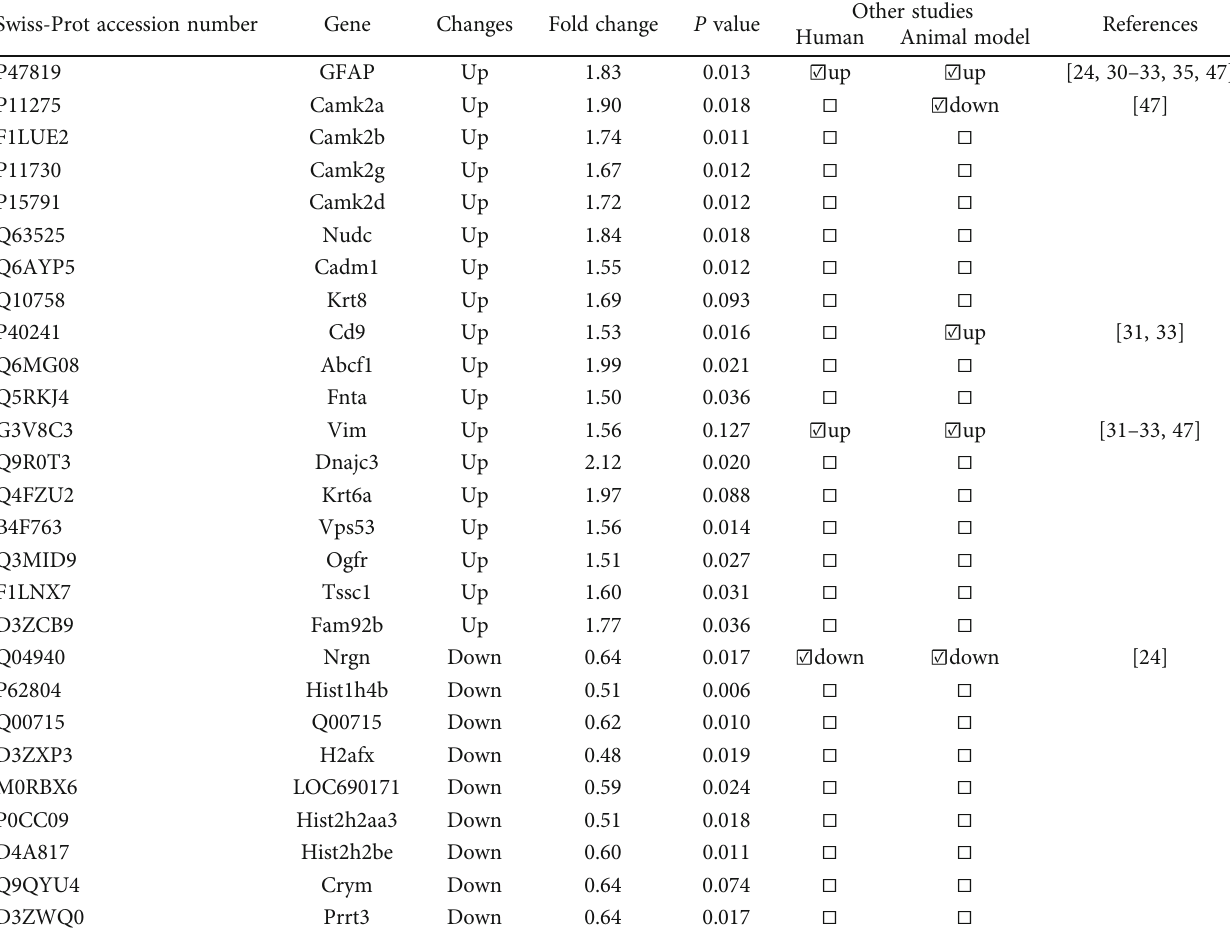
Table 2: Information of the 27 DEPs based on iTRAQ proteomics